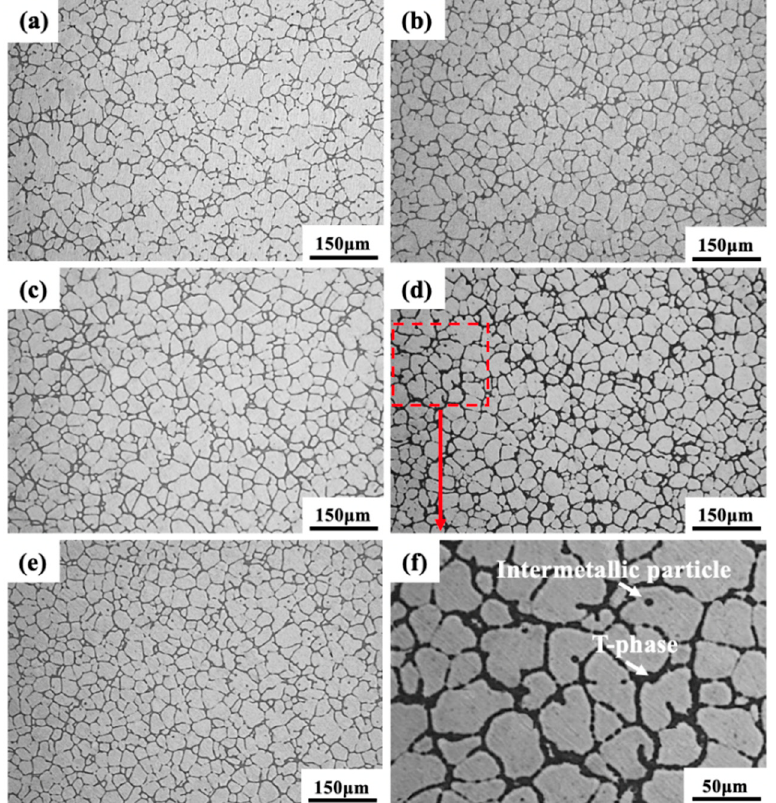
Figure 3. Optical micrographs of the peak-aged alloys: ( a ) ZE41, ( b ) ZE41-0.2Ca, ( c ) ZE41-0.2Ca- 0.1Sr, ( d ) ZE41-0.2Ca-0.2Sr, ( e ) ZE41-0.2Ca-0.4Sr and ( f ) partial enlarged drawing of the ZE41- 0.2Ca-0.2Sr alloy [25].